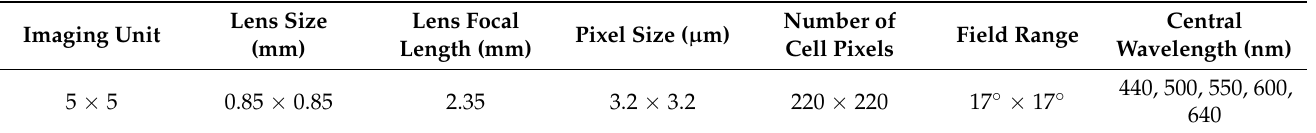
Table 2. Specifications of the TOMBO prototype.